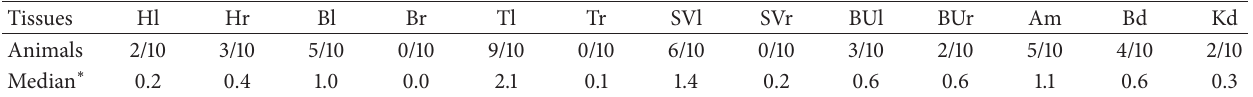
Table 4: Distribution, frequency, and intensity of inflammatory lesions in genitourinary organs of rams experimentally infected with Histophilus somni